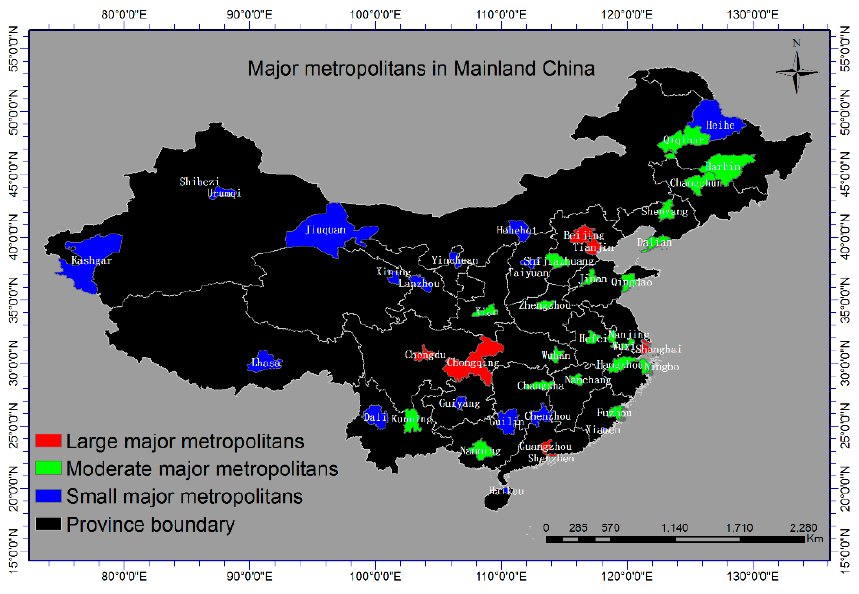
Figure 3. Major Metropolitans in Mainland China.